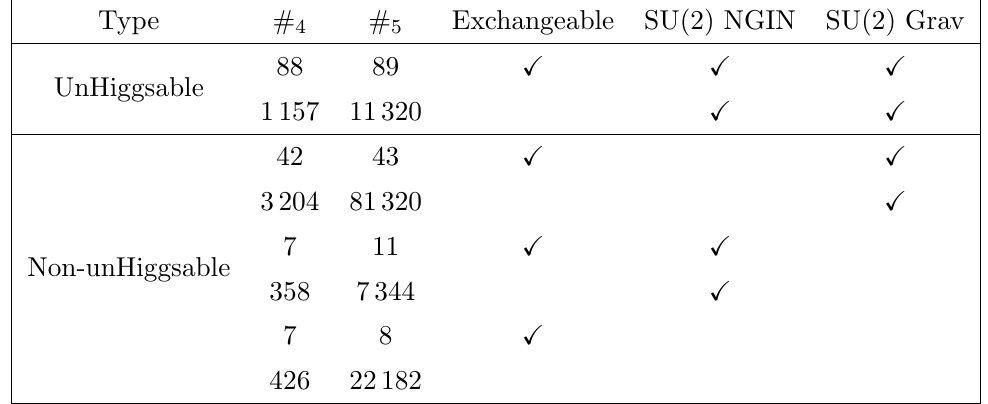
Table 6 . Classes of j q j (cid:20) 4 and j q j (cid:20) 5 models satisfying the U(1) AC conditions, as well as the integrality and non-negativity conditions. Classes are grouped into two types: those unHiggsable to an anomaly-free SU(2) model and those that are